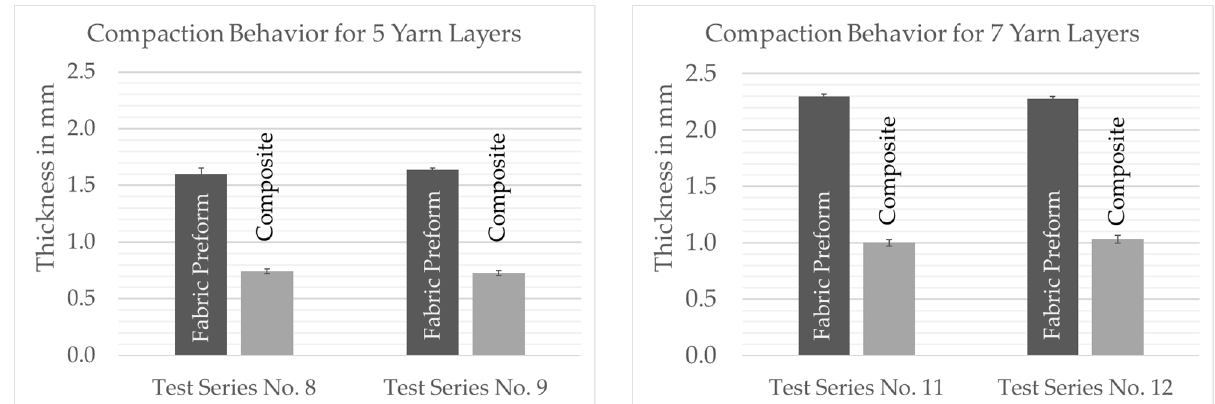
Figure 15. Comparison between different layup variants and preform compaction behavior during consolidation.